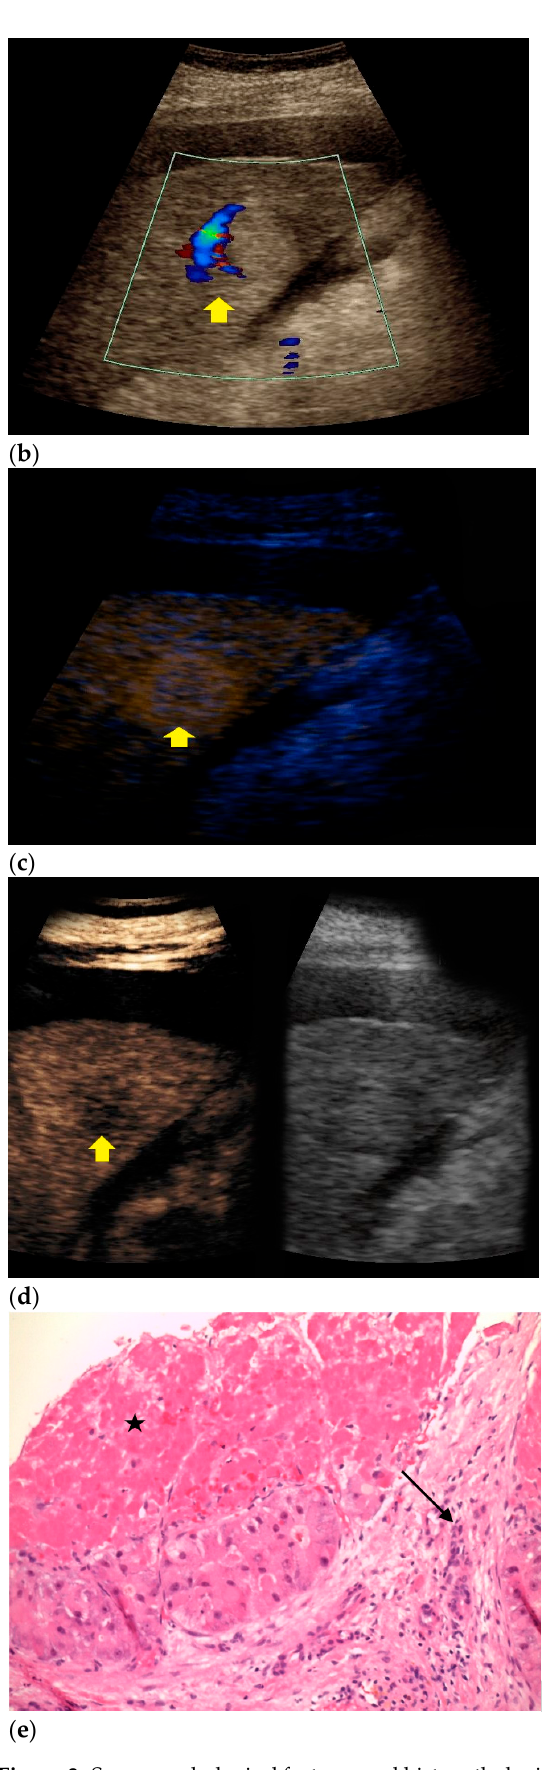
Figure 3. Sonomorphological features and histopathological assessment of poorly differentiated hepato- cellular carcinoma (HCC). ( a ) Homogeneous, hyperechoic liver lesion in native B-mode (yellow arrow). ( b ) The lesion shows peripheral hypervascularization in Doppler mode (yellow arrow). ( c ) In